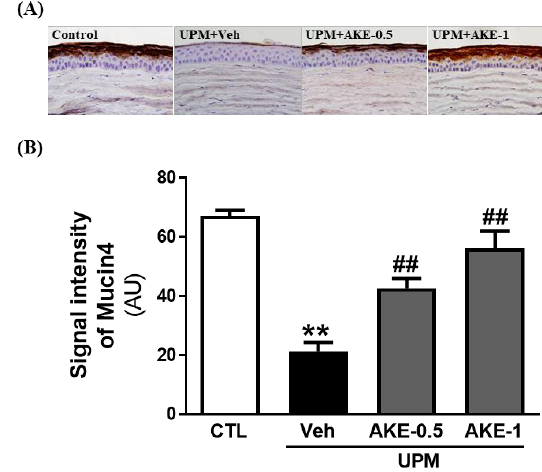
Figure 4. Effects of AKE on mucin-4 integrity in the UPM exposure-induced KCS model. ( A ) Representative images of mucin-4. ( B ) Quantitative analysis of the signal intensity of mucin-4. Control group: CTL; vehicle group: Veh; 0.5 mg/mL AKE-treated group: AKE-0.5; and 1 mg/mL AKE-treated group: AKE-1. Data shown are mean ± standard error of the mean (n ≥ 8). ** p < 0.01 vs. CTL, ## p < 0.01 vs.